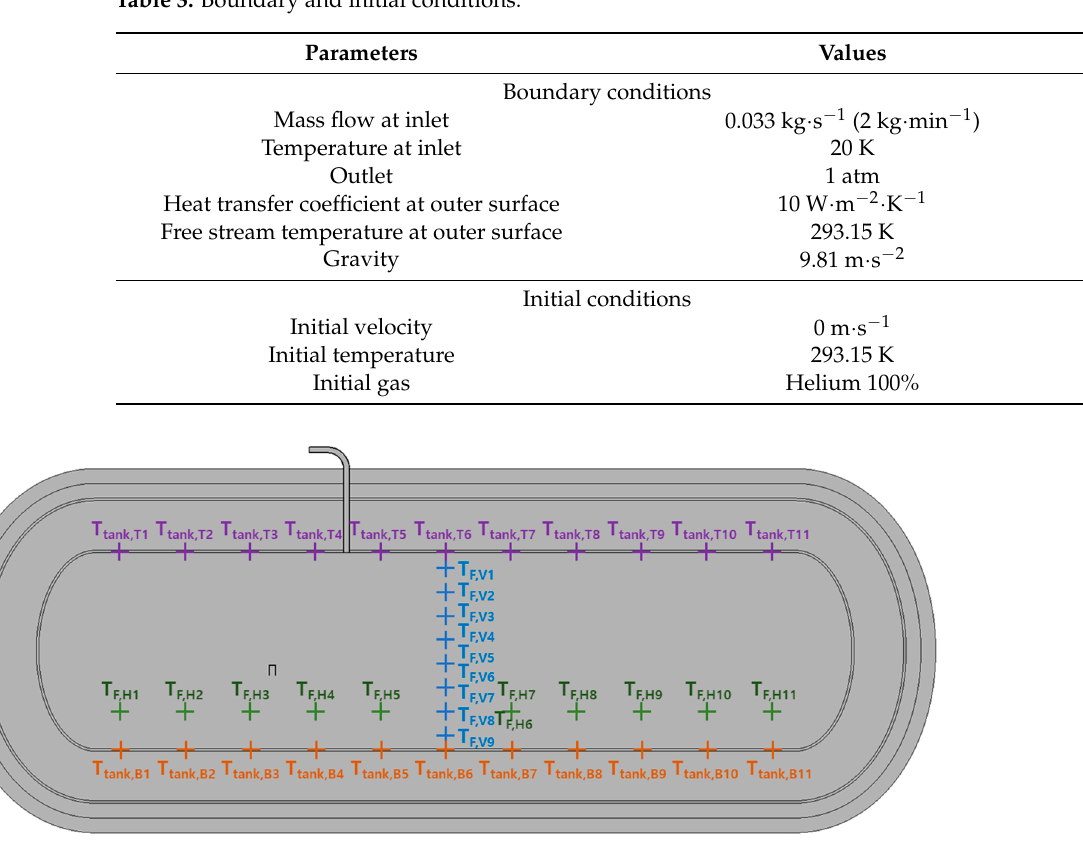
Figure 2. Temperature measurement